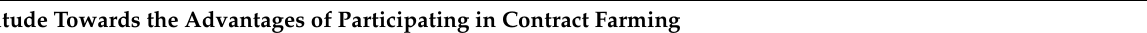
Table 1. Specific questions for each factor in the TPB.